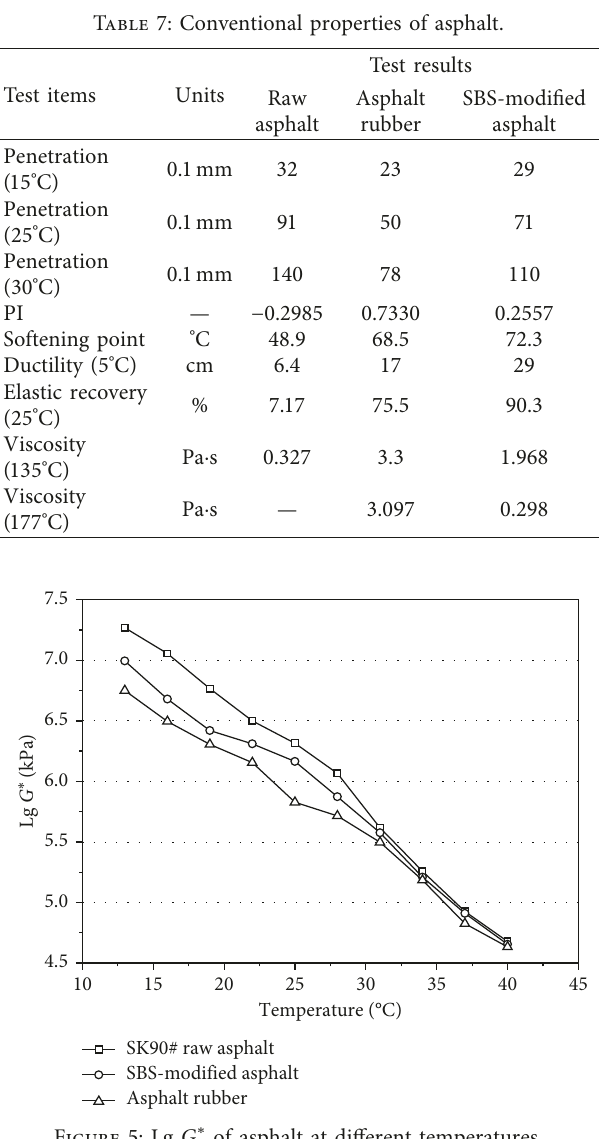
Figure 5: Lg G of asphalt at different temperatures. ∗